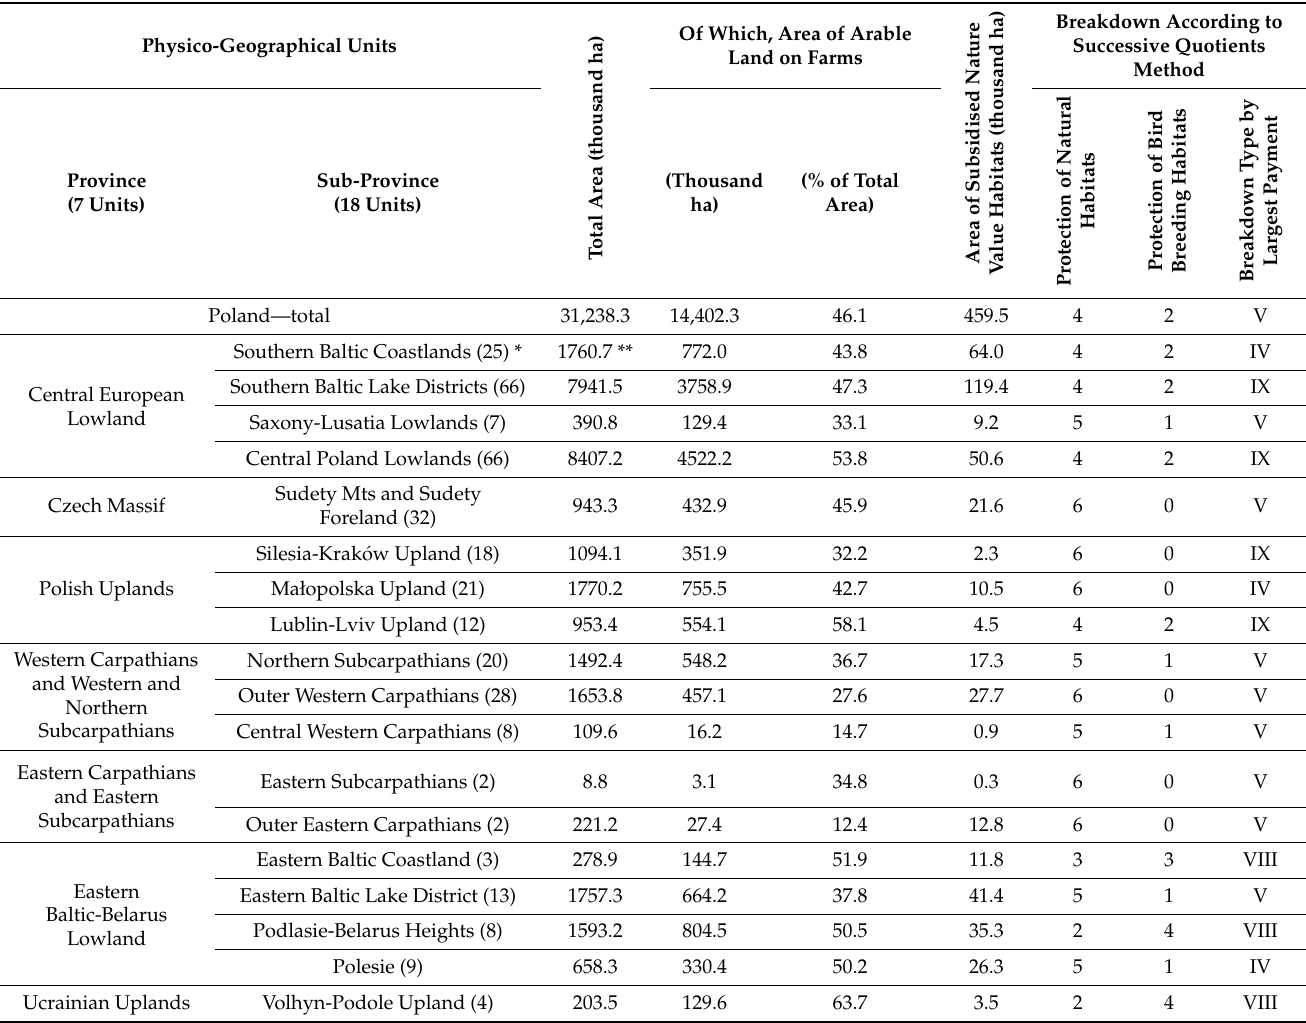
Table 2. Environmentally valuable habitats—breakdown of farmland subsidised under the RDP 2014–2020 agri- environment-climate